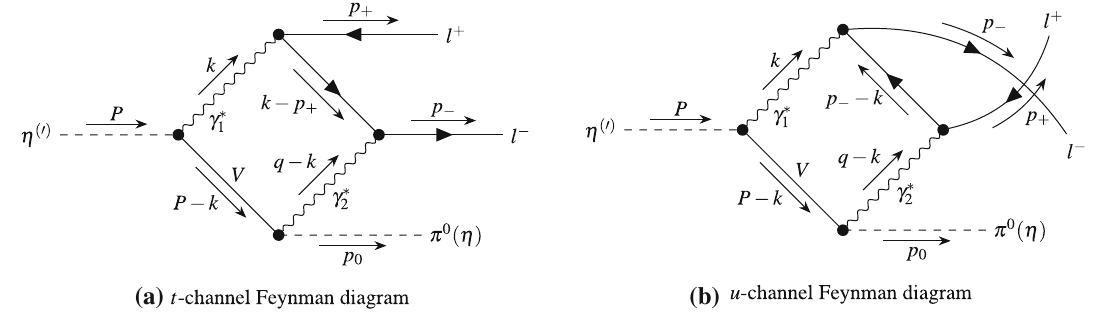
Fig. 1 Feynman diagrams contributing to the C -conserving semileptonic decays η ( (cid:2) ) → π 0 l + l − and η (cid:2) → η l + l − ( l = e or μ ). Note that ω , q = p + + p − and V = ρ 0 ,